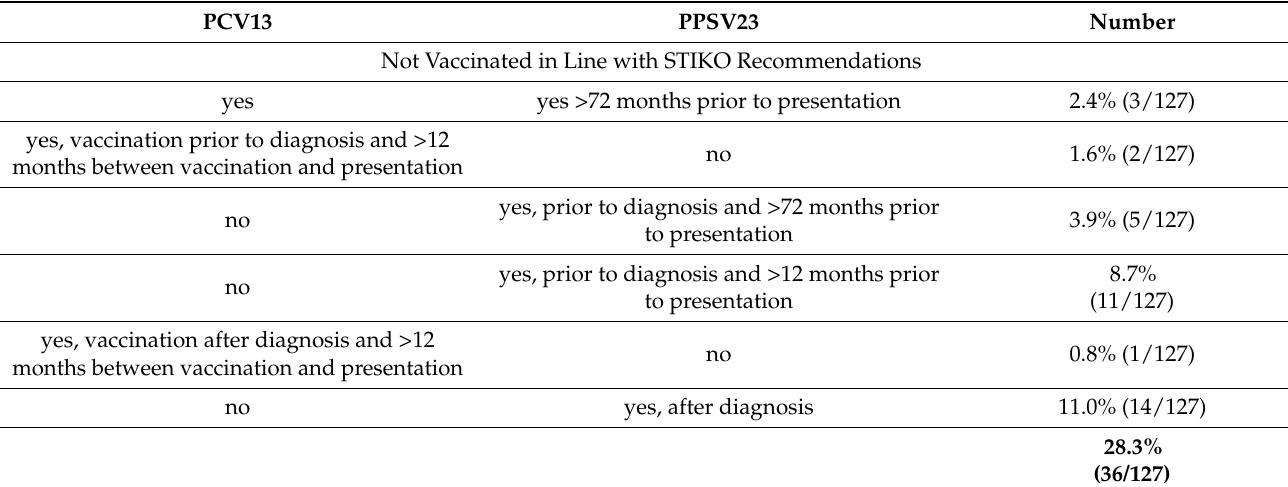
Table 2. Deviation from STIKO recommendations in patients who received a pneumococcal